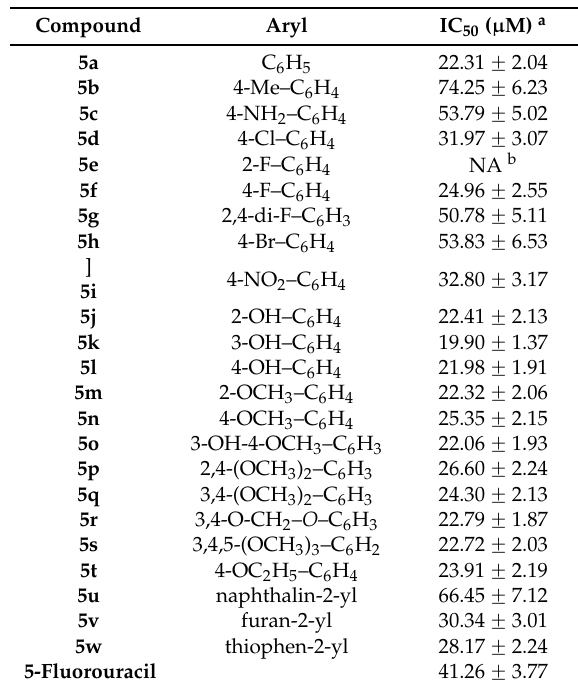
Table 4. In vitro anti-proliferative activity of compounds 5a – w against breast MDA-MB-468 cancer cell